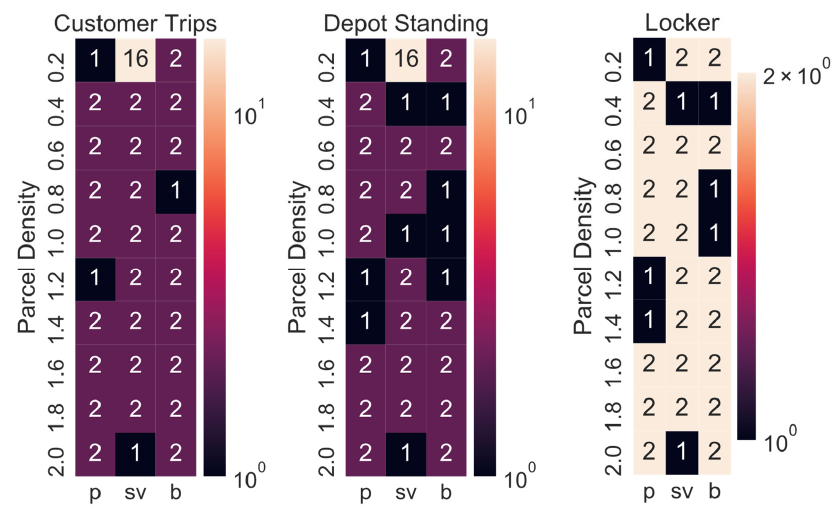
Figure 12. Increase in the optimal number of CDPs (2: doubled number of CDPs).